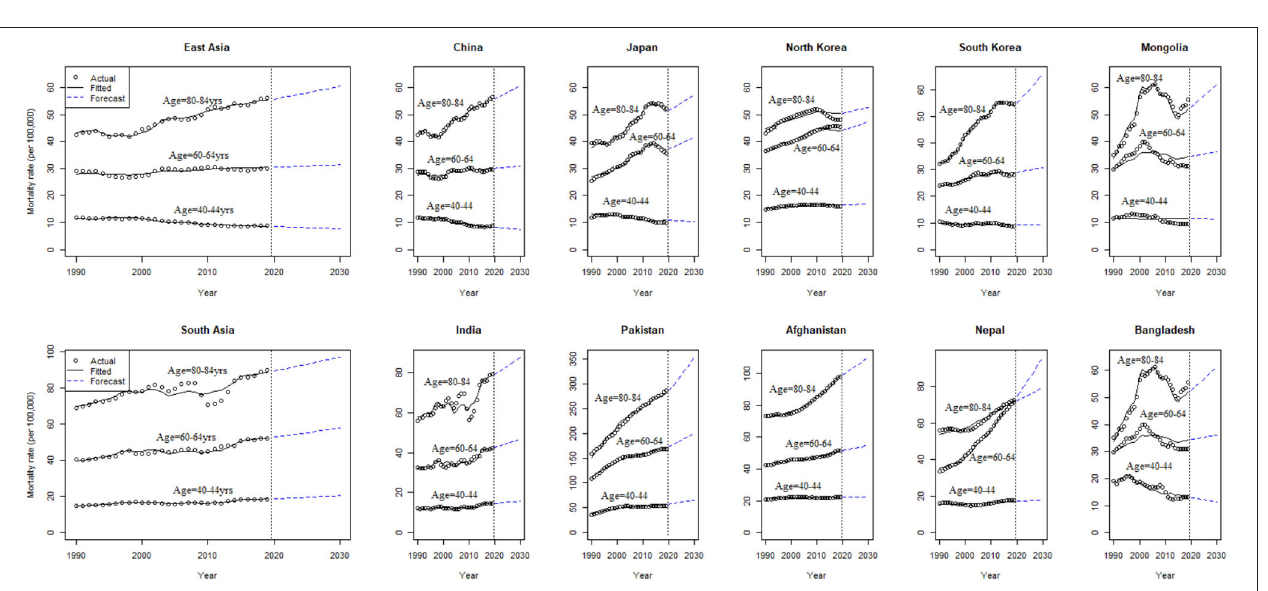
Frontiers in Nutrition | www.frontiersin.org